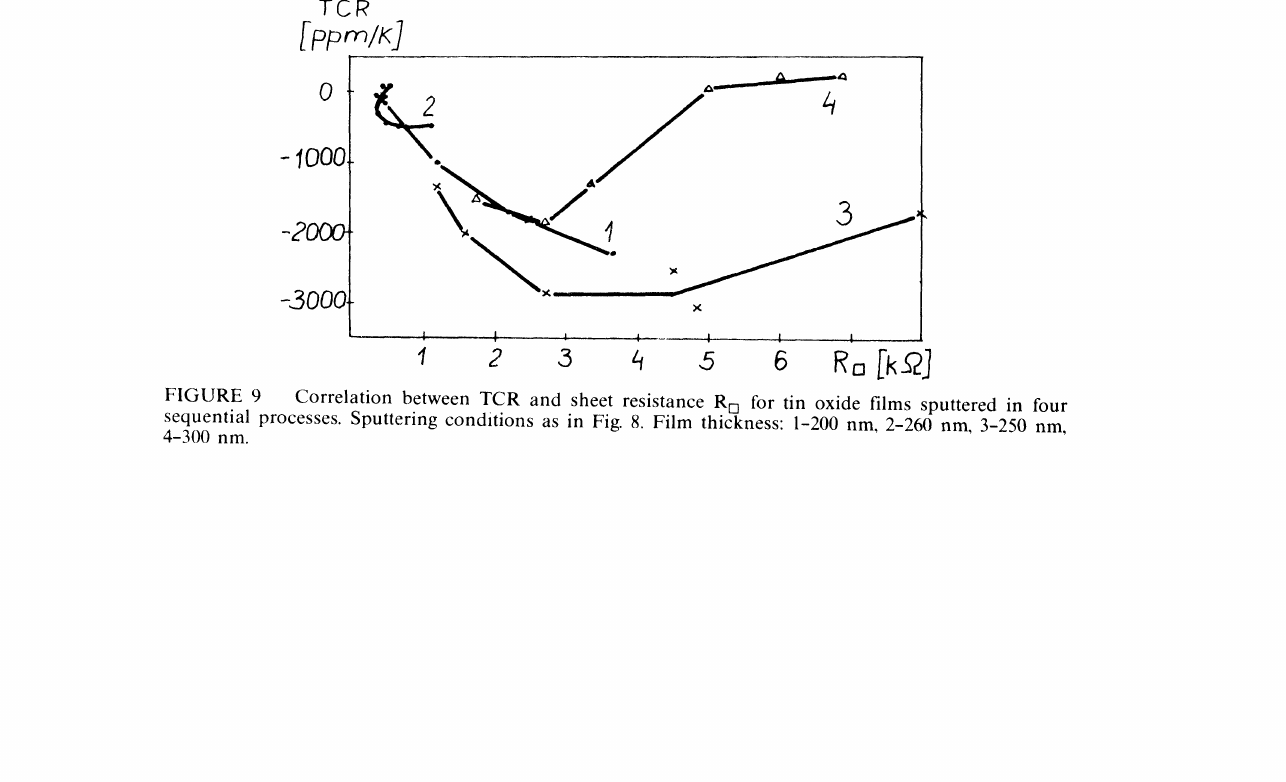
Correlation between TCR and sheet resistance R n for tin oxide films sputtered in four sequential processes. Sputtering conditions as in Fig. 8. Film thickness: 1-200 nm, 2-260 nm, 3-250 nm, 4-300